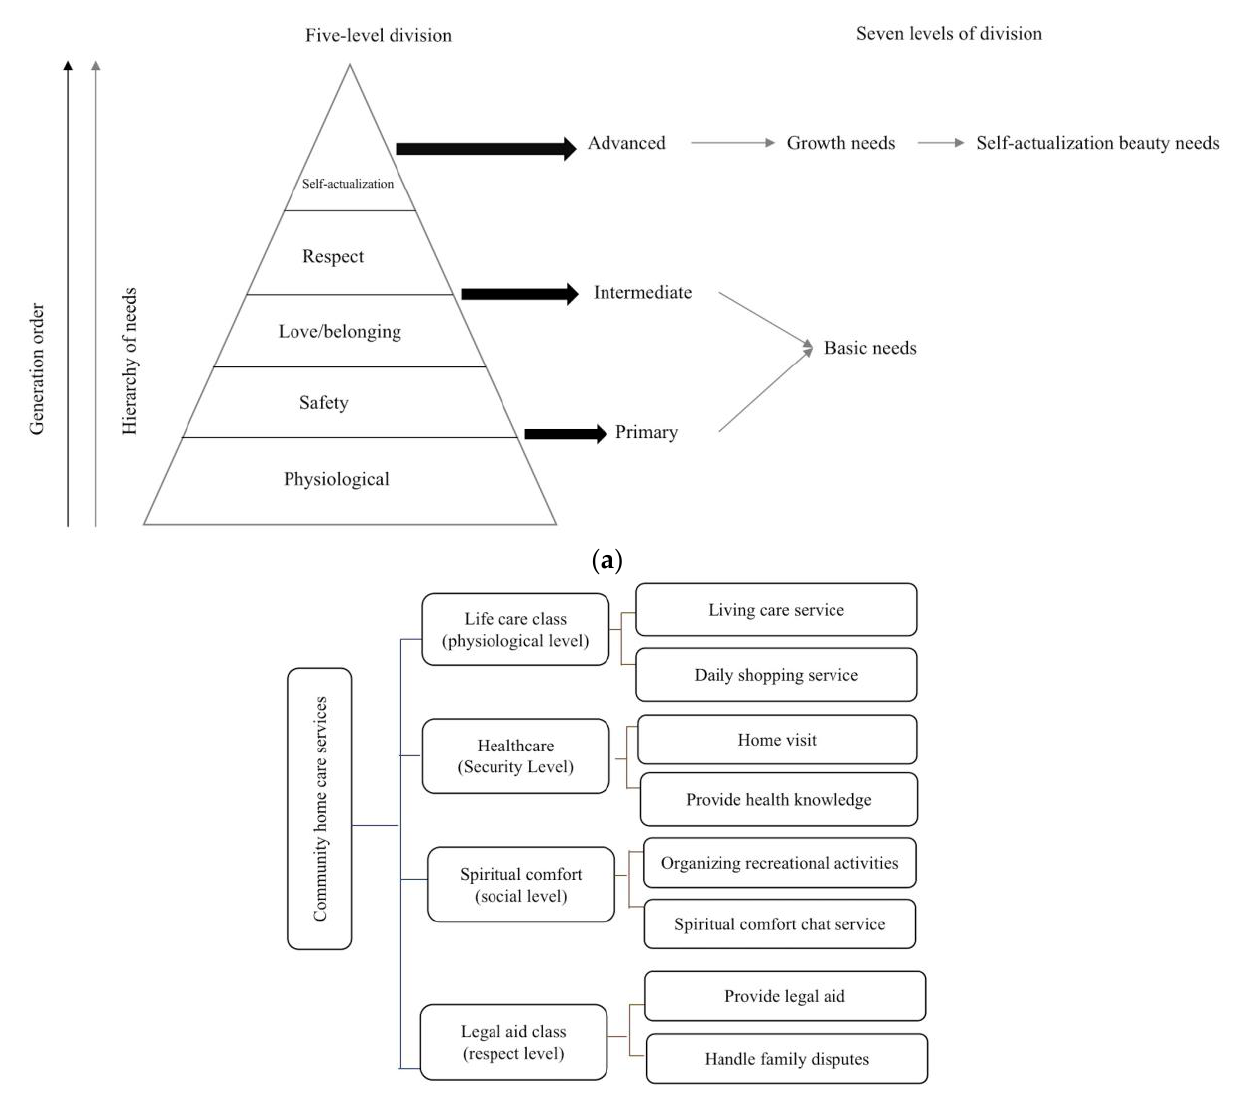
Figure 2. Hierarchy of demand for elderly services under the division theory. ( a ) Hierarchy of needs theory; ( b ) Hierarchy of needs for senior care services.